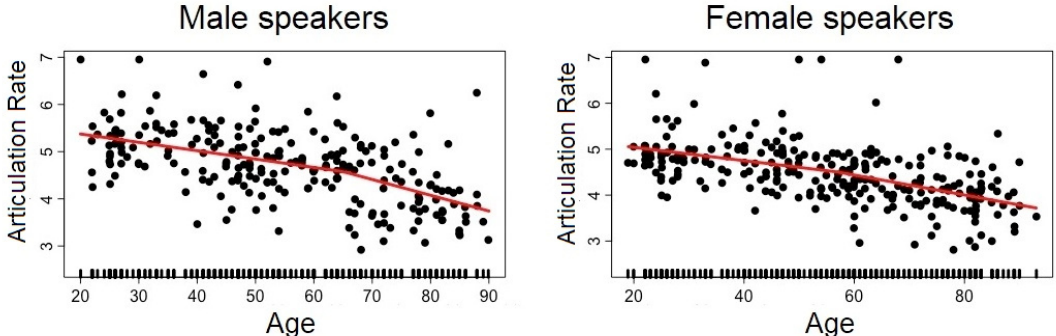
Figure 1. PitchMean ( y -axis) as a function of age ( x -axis) in speakers with the hinge function (red curve) of the MARS model for Male ( left ) and Female ( right ) speakers.